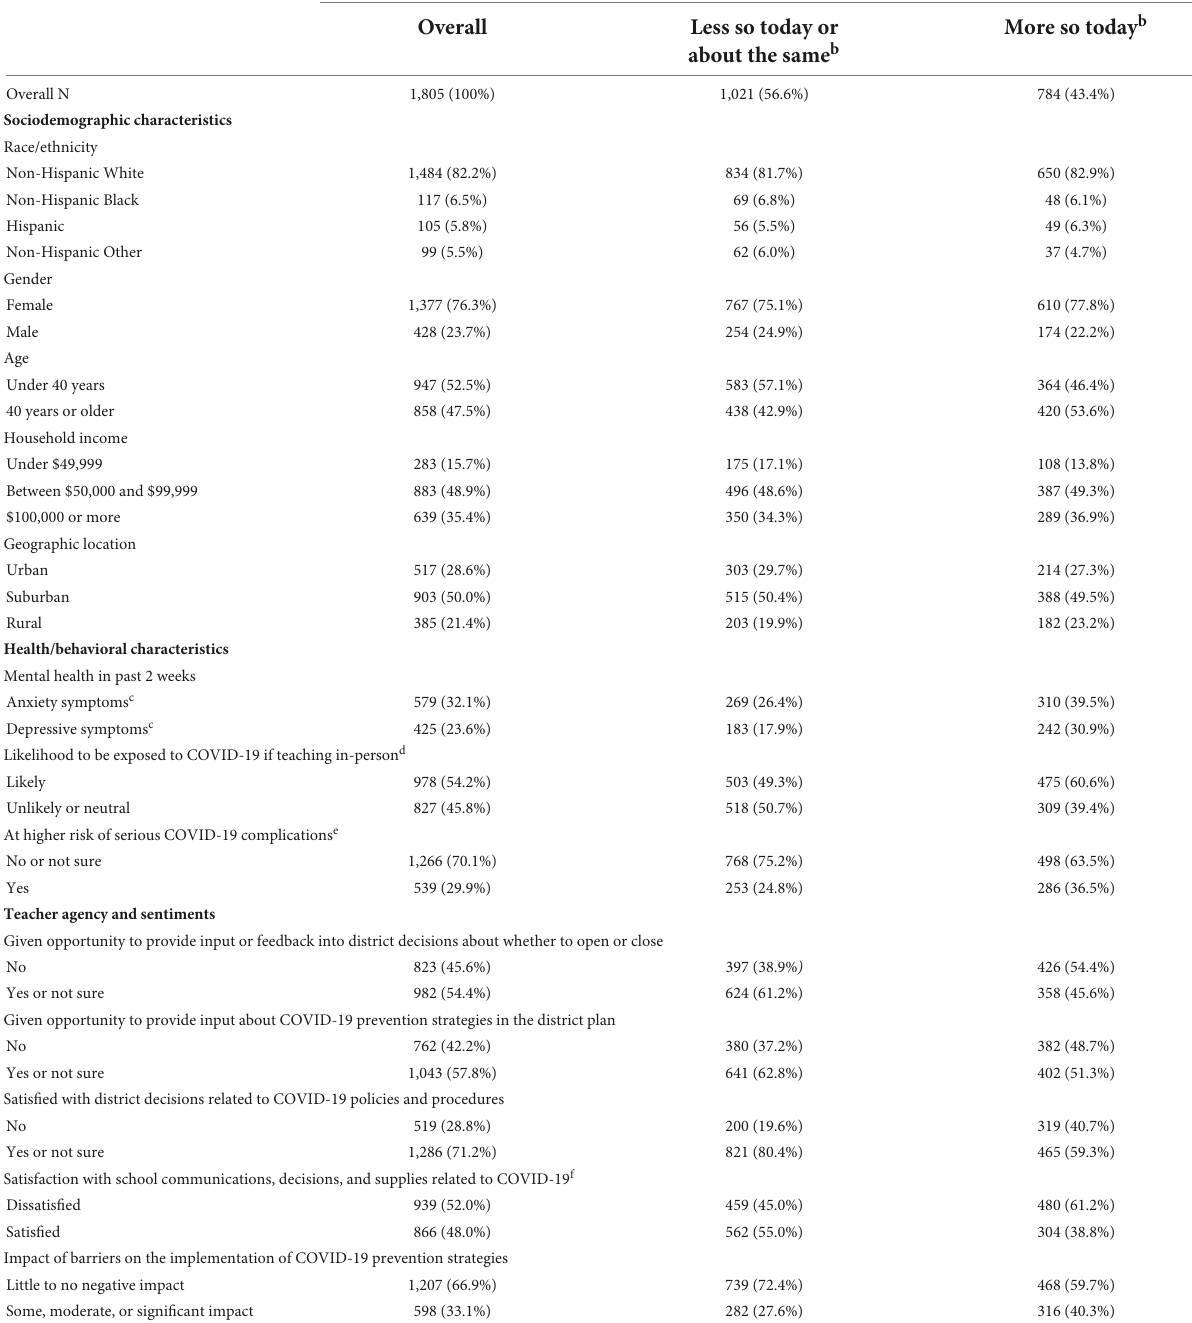
TABLE 1 Characteristics of respondents broken down by teachers’ intention to leave the profession as compared to recalled pre-pandemic intentions to leave, May–June